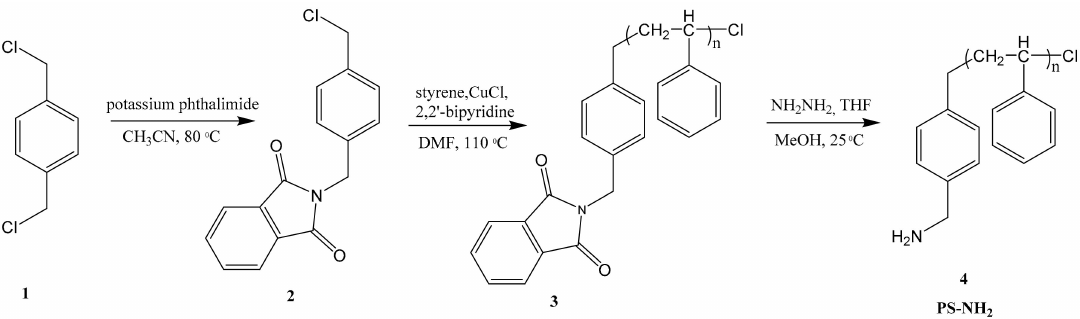
Figure 1. Gel permeation chromatography (GPC) curves of PS–NH 2 with different molecular weight.